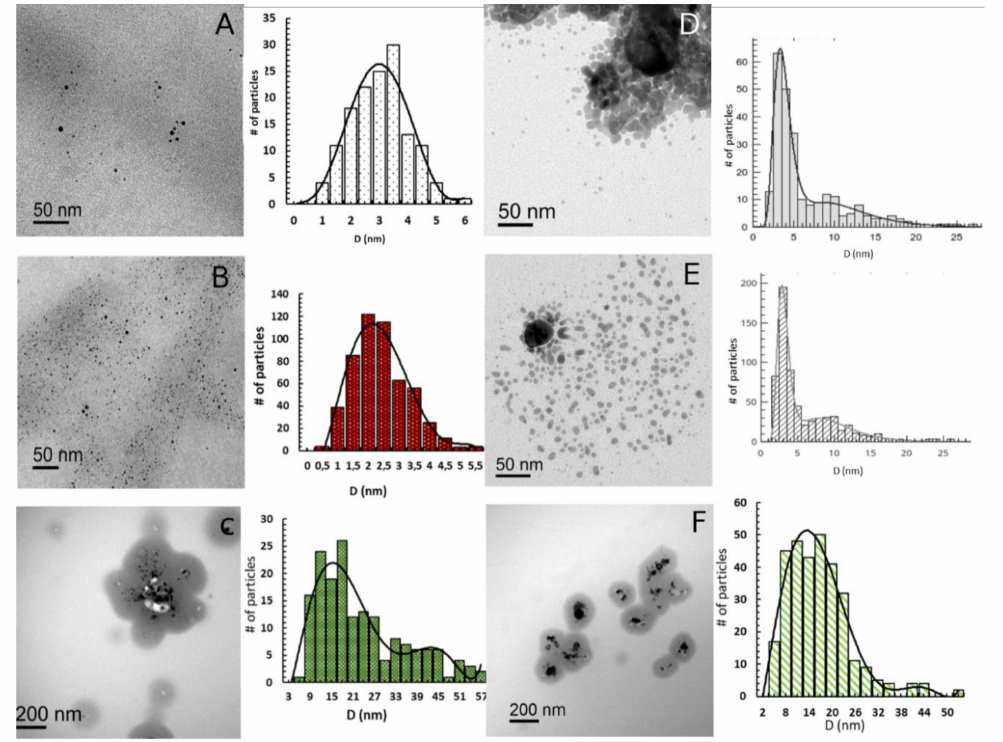
Figure 3. TEM bright field images of Ag / S 1 and Ag / S 8 samples, with their respective size distribution histogram. The histogram was obtained counting 300 NPs on average. ( A ) Ag / S 8 G, ( B ) Ag / S 8 R, ( C ) Ag / S 8 V, ( D ) Ag / S 1 G, ( E ) Ag / S 1 R and ( F ) Ag / S 1